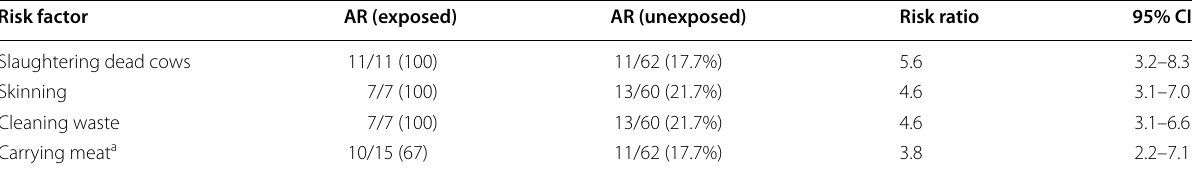
a On shoulders, arms, on a stick, bicycle and motorcycle